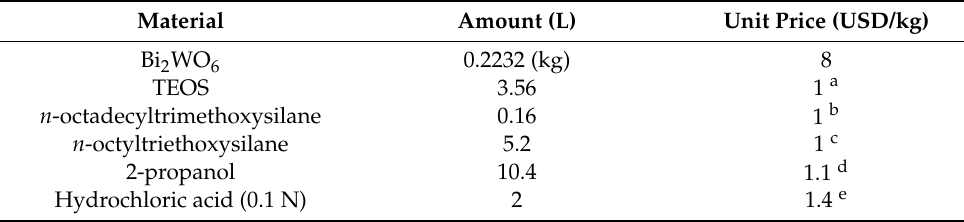
Table 1. Raw materials needed to produce AquaSun, amount ( × 4000 lab-scale), and unit price. Material Amount (L) Unit Price (USD/kg) Bi 2 WO 6 0.2232 (kg) 8 TEOS 3.56 1 a n -octadecyltrimethoxysilane 0.16 1 b n -octyltriethoxysilane 5.2 1 c 2-propanol 10.4 1.1 d Hydrochloric acid (0.1